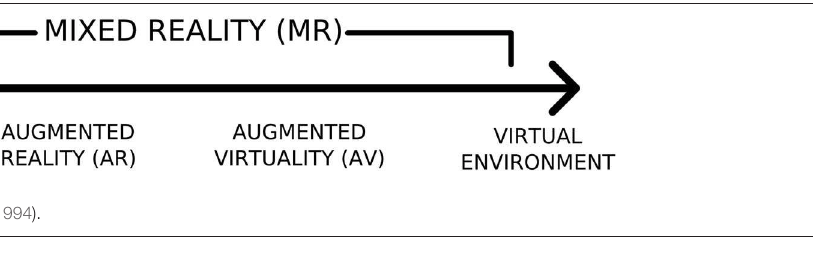
virtual objects into the real world, whereas augmented virtuality (AV) adds real items into a virtual environment (VE). The extremes of this classification are the real world and virtual reality (VR), i.e., a space that is purely virtual without the integration of real-world